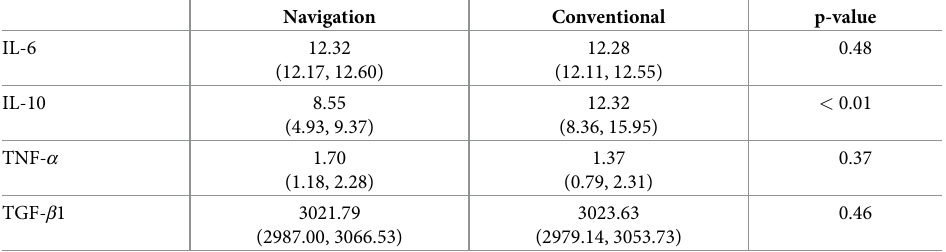
Table 6. Concentrations of inflammatory markers in Hemovac drainage fluid fromeach TKA